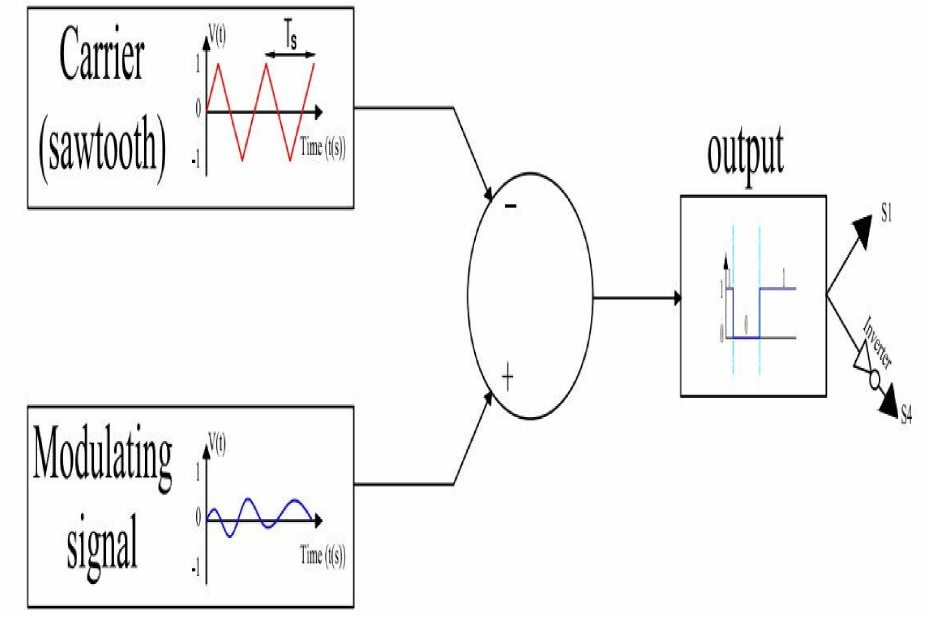
Figure 22. Schematic diagram of generating PWM gate pulses for S4 and S1.